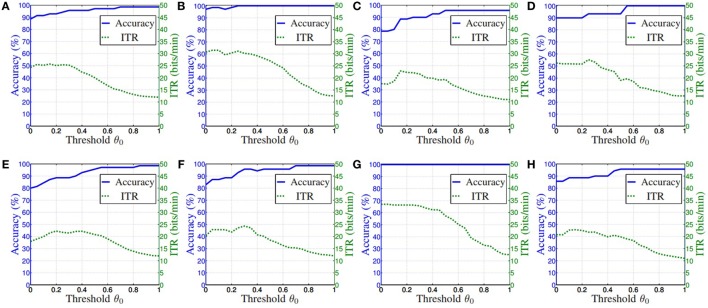
The relationship among accuracy, ITR and θ0. (A)–(H) Subjects 1–8.